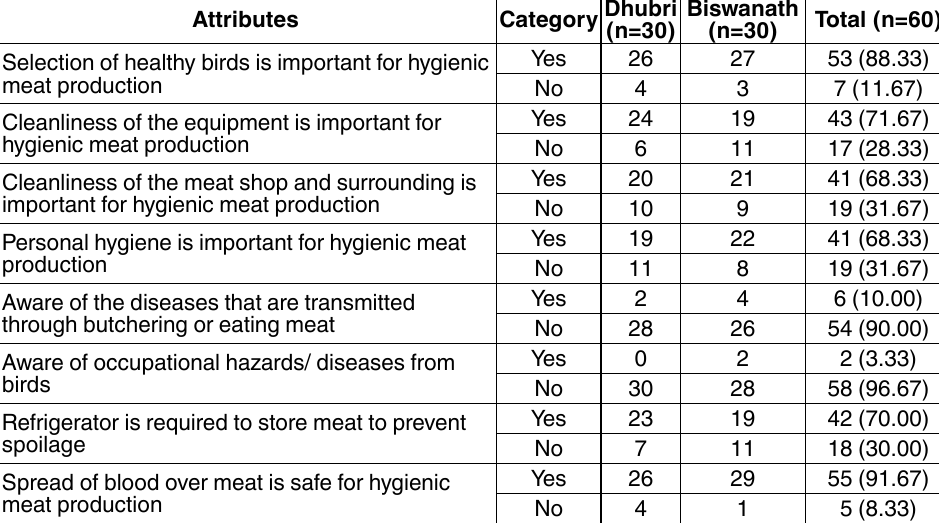
table 6. Perception of butchers regarding maintenance of meat hygiene